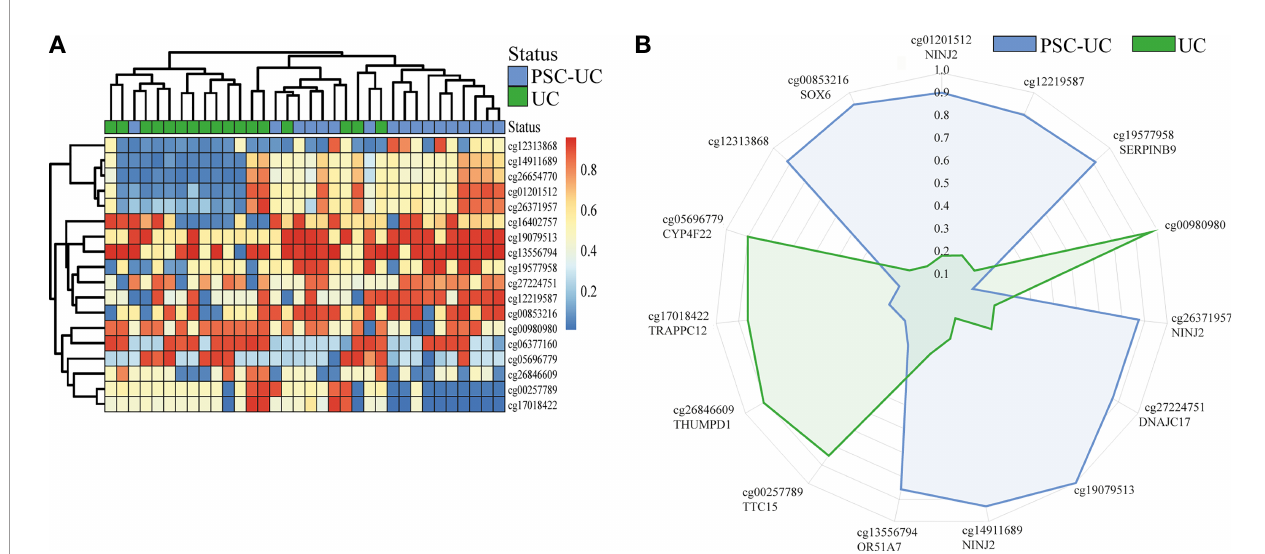
FIGURE 2 | Gradient boosting analysis distinguishes PSC-UC from UC. (A) Heatmap of 18 differentially methylated positions contributing to the predictive model distinguishing PSC-UC from UC. (B) Radar plot depicting the 15 most predictive CpG loci that are capable of distinguishing patients with PSC-UC from UC. The axes represent the mean scaled changes for the top 15 most discriminative CpG